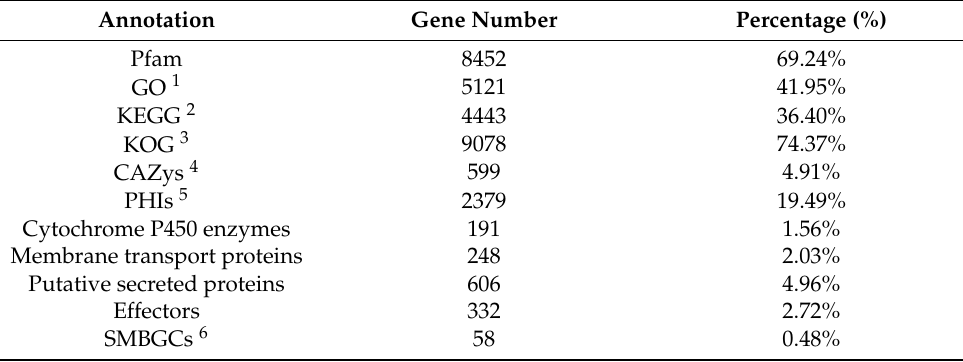
Table 3. Summary of Gene Functional Annotation.